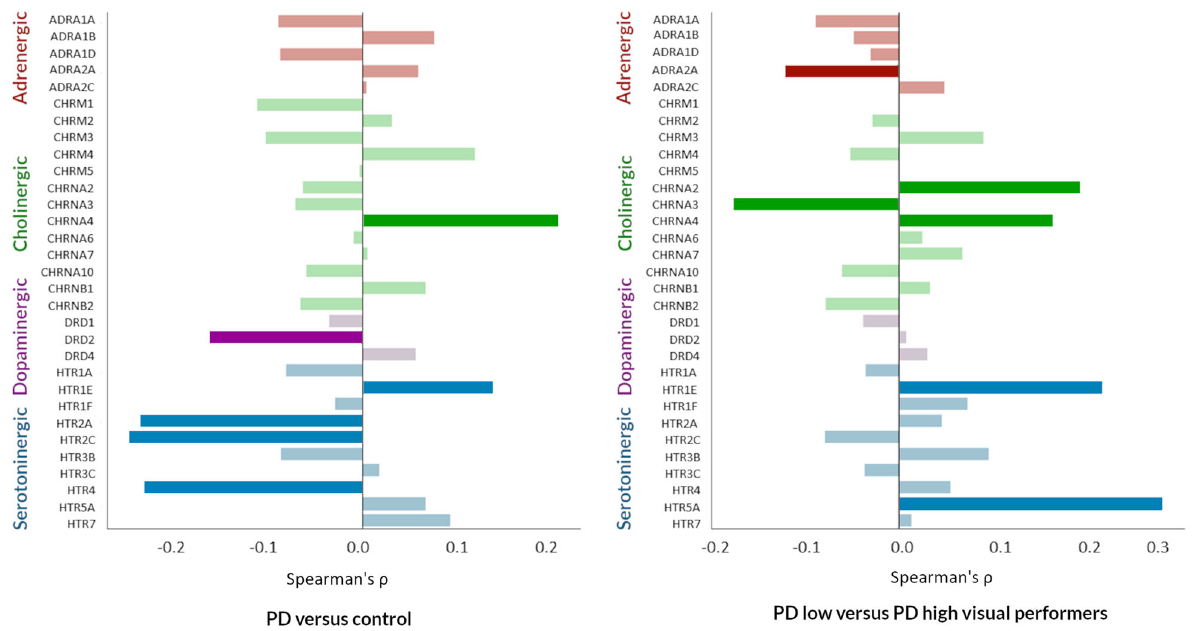
Fig. 5 Correlation between regional cortical expression of neurotransmitter receptor genes and structural – functional connectivity decoupling in PD. Spearman correlations between regional cortical expression of adrenergic, cholinergic (muscarinic and nicotinic), and dopaminergic receptors and difference in structural – functional connectivity coupling seen between PD and controls (left) and PD low visual performers vs PD high visual performers (right). Full gene names in Supplementary Table 2. Results colour coded according to receptors: red: adrenergic, green: cholinergic, purple: dopaminergic, blue: serotoninergic receptors. Bars with stronger (rather than fainter) colours indicate statistically signi fi cant relationships (FDR-corrected p > 0.05).